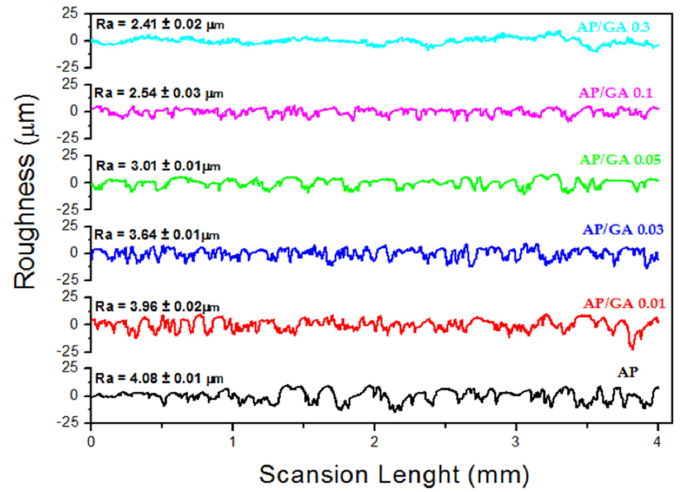
Figure 4. Surface roughness profiles of AP and AP/GA samples at different wt. % of GA. In the images associated with the graph of Figure 5 and Table 1, it is possible to see how all the AP/GA coatings exhibit contact angles (and therefore wettability) much higher compared to the AP coating whose contact angle is lower than 90°. The apparent static Wenzel contact angle θ w depends on the morphology of the surface. Every surface, in fact, presents heterogeneities and when there is a full contact between the liquid and the substrate, or if there is air trapped inside the surface roughness, the measured contact angle of contact measured θ w differs from the ideal one θ Y (Young contact angle). Con- sidering that hydrophilic coatings have a contact angle θ < 90° while the hydrophobic ones have θ > 90, the hydrophilic features of AP change after the treatment with glutaraldehyde in hydrophobic ones. Thus, both Young and Wenzel contact angles grow with the increas- ing GA amount with p < 0.0001. Furthermore, the comparison between the contact angles θ w e θ Y of the AP and AP/GA coatings at the different amount of GA shows a lower value of θ Y with respect to θ w for all coatings if normalized to roughness value, according to the Equation (3) (see Table 1). Figure 5. Comparison of contact angles θ w and θ Y of AP and AP/GA coatings at different GA con- tent.